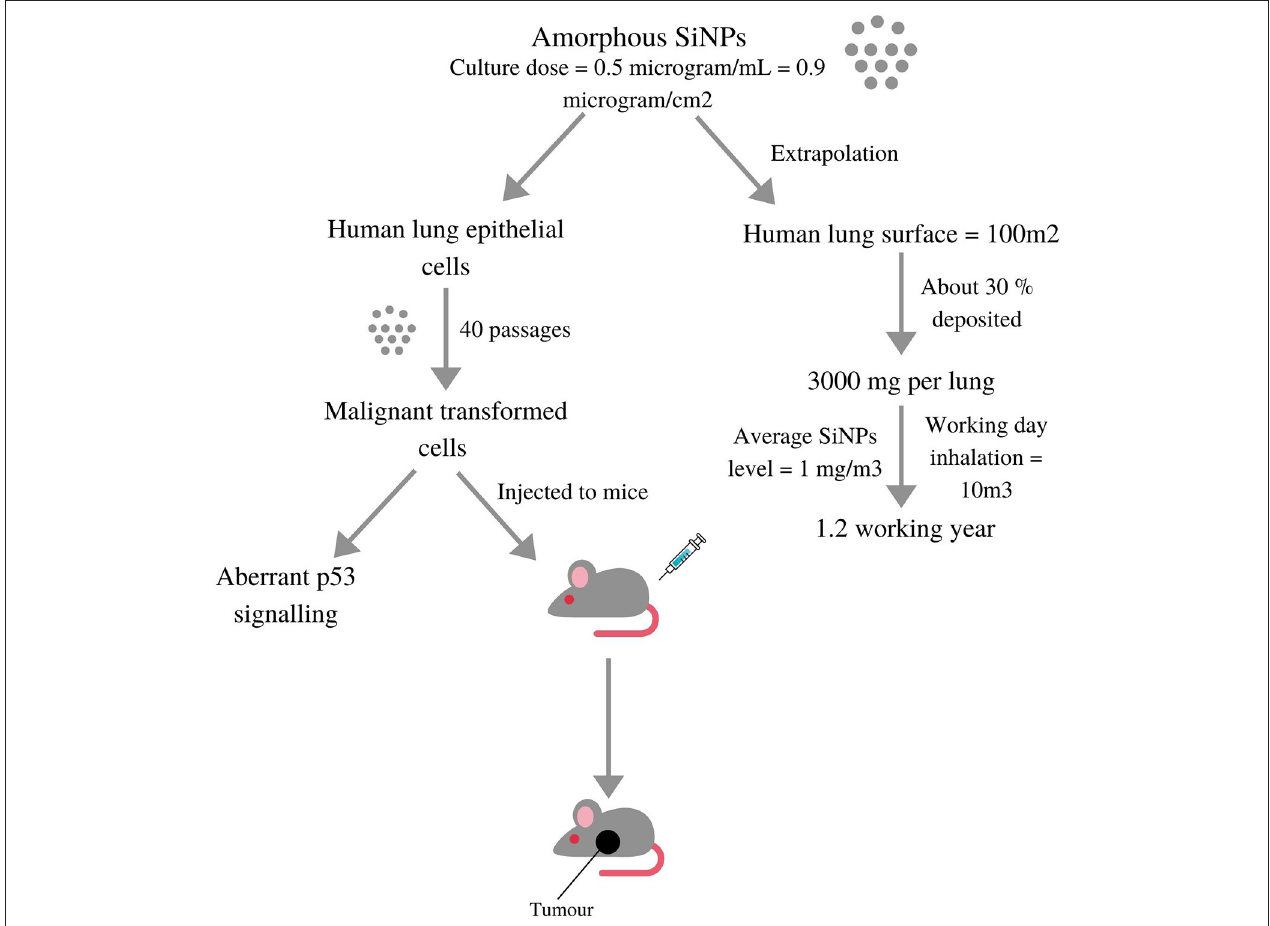
FIGURE 5 | Diagrammatic depiction of a study where Silica nanoparticles were deposited in lungs via p53 signalling and then tested in-vitro on lung cell models as well in-vivo on live rats induced aberrant p53 signalling and malignant tumours, respectively (adopted from Stueckle et al., 2017).